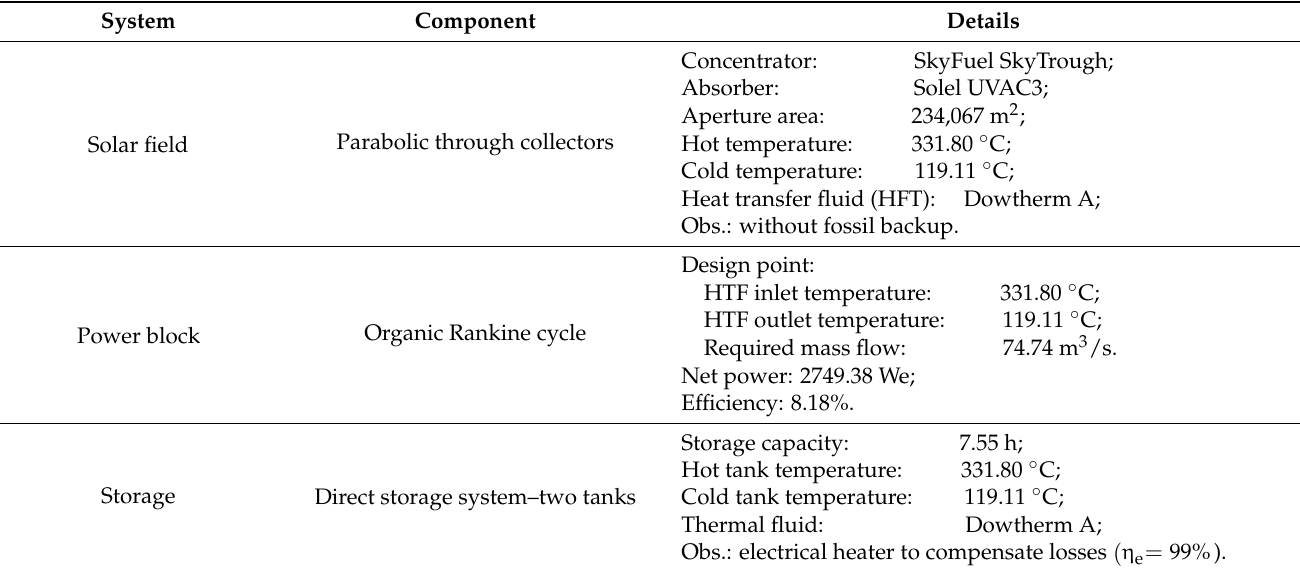
Table 3. Details of study case solar thermal power plant